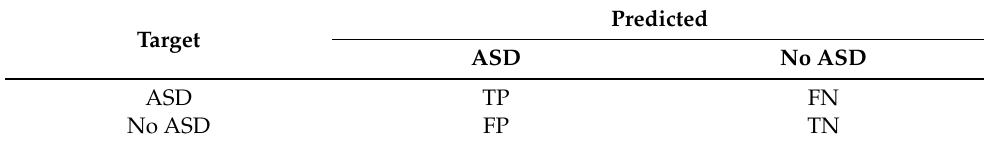
Table 3. Confusion matrix for